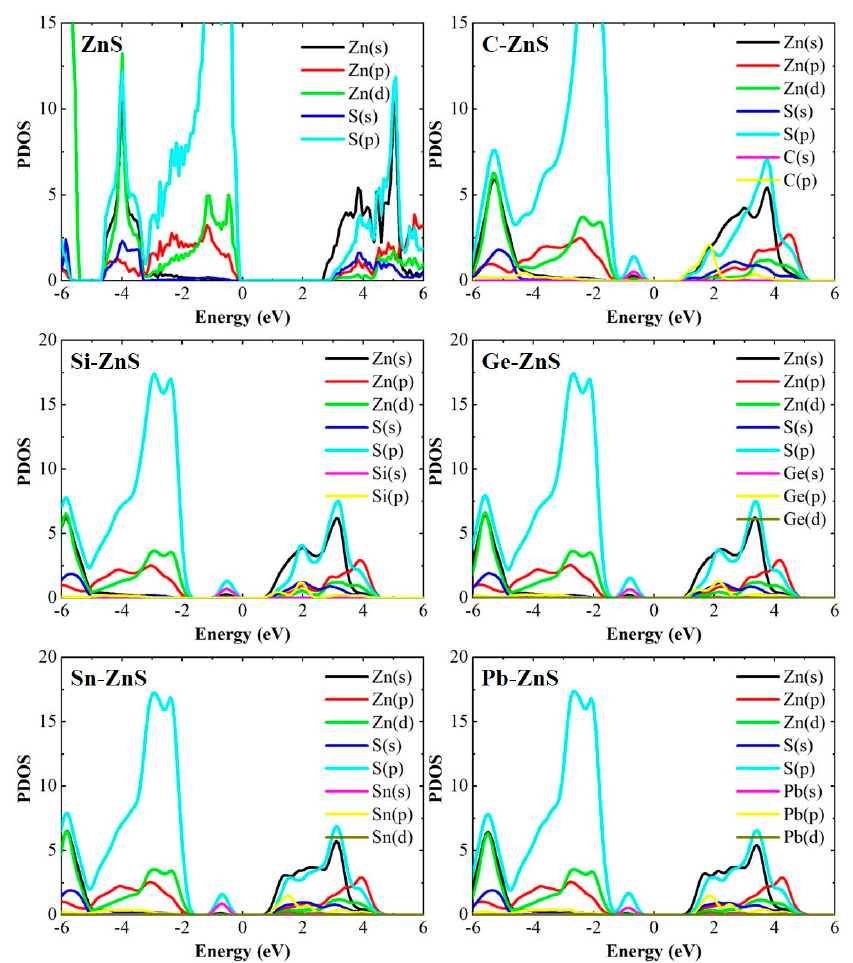
Figure 7. The PDOS of monolayer tetragonal ZnS and the corresponding doped models. Figure 8a,b shows the real ( ε 1 ) and imaginary ( ε 2 ) parts of the calculated dielectric function for the ZnS monolayer and the doped models. The ε 1 of the doped models is larger than that of the ZnS monolayer when the energy is smaller than 2.1 eV, while they are smaller than that of the ZnS monolayer in the energy range of 2.1 − 6.5 eV. Beyond the scale, they are in good agreement. For the ε 2 , the values of doped models are larger than that of the ZnS monolayer in 1.2 − 6.1 eV, while they are smaller than that of ZnS in 6.1 − 7.0 eV. The values of these models are very consistent when the energy is above 7.0 eV. The optical absorption α ( ω ) of the doped ZnS models are shown in Figure 8c, which are ob- tained from ε 1 and imaginary ε 2 by the following formula: α(cid:4666)ω(cid:4667) = √2ω 𝑐